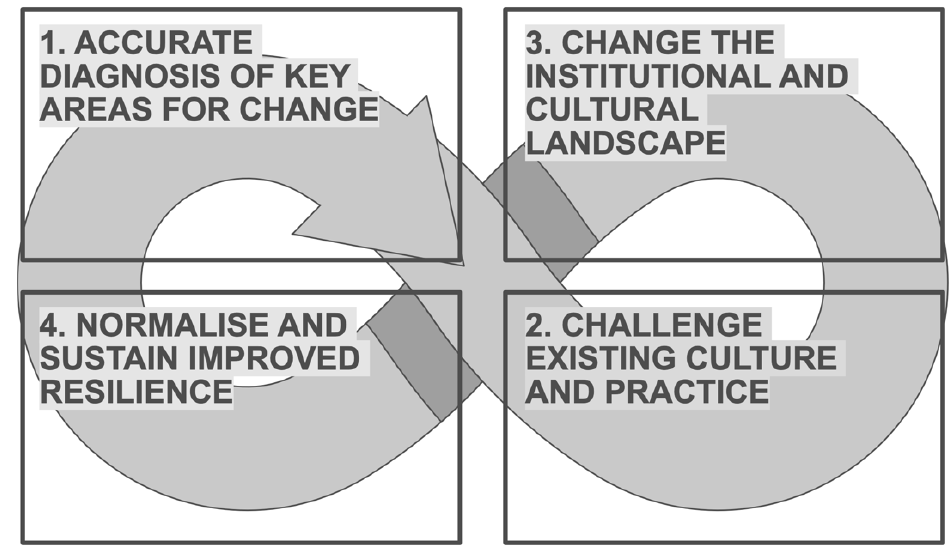
Figure 2. Adaptive cycle of resilience to build slavery-free communities (originally in Gardner et al. [8]).